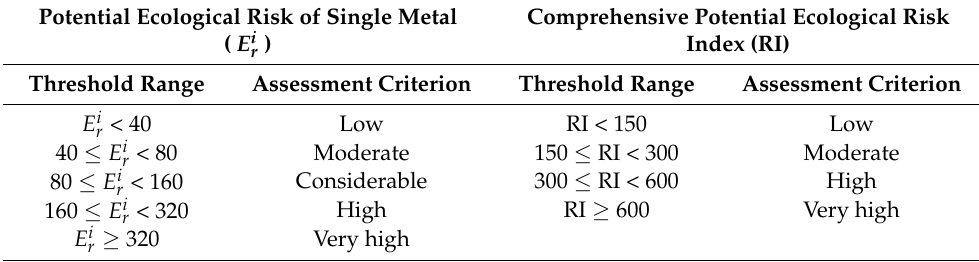
Table 1. Classification of the potential ecological risk index. Potential Ecological Risk of Single Metal